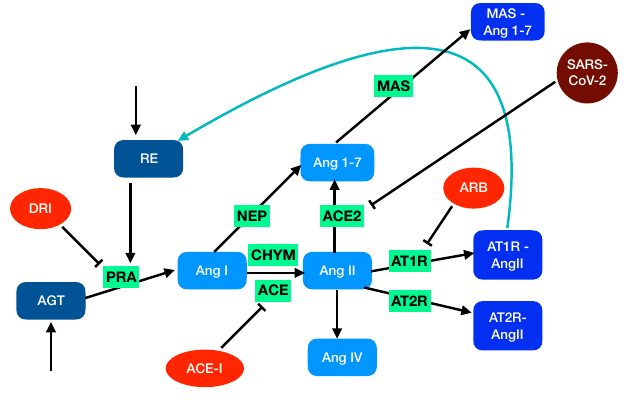
Figure 1. Schematic representation of RAS. In the unperturbed system, soluble proteins that are explicitly considered in the model are in blue grey, the peptides in light blue, and the peptide-bound membrane proteins in medium blue. The activities and enzymes considered only through reaction rates are in green. The feedback loop is indicated in blue. In the perturbed system, the drugs are in orange and SARS-CoV-2 in dark